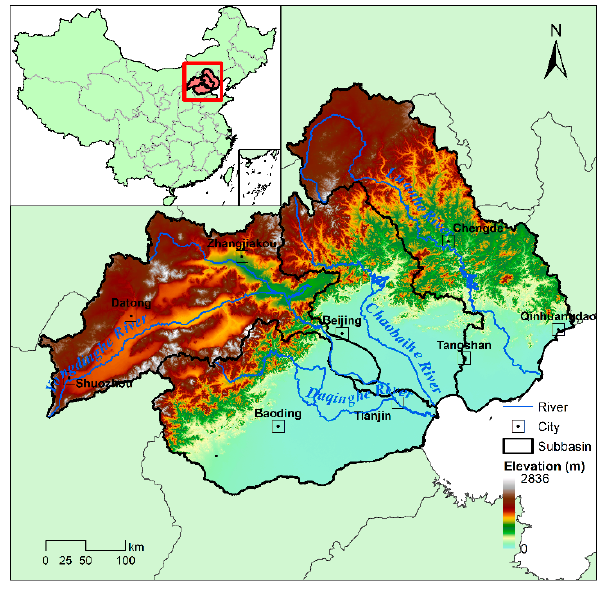
Figure 1. Locations of the study area.